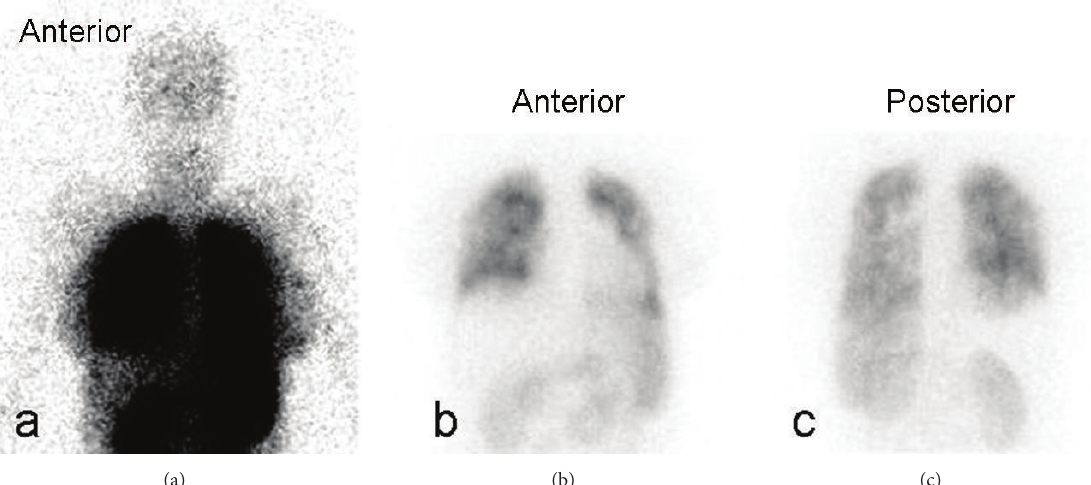
Figure 1: Images of pulmonary perfusion scintigraphy. Normal uptake in lungs was observed together with extrapulmonary uptake in cranium, spleen, and kidneys (a, b, and c) caused by systemic accumulation of Tc99m-MAA due to right to left shunt.